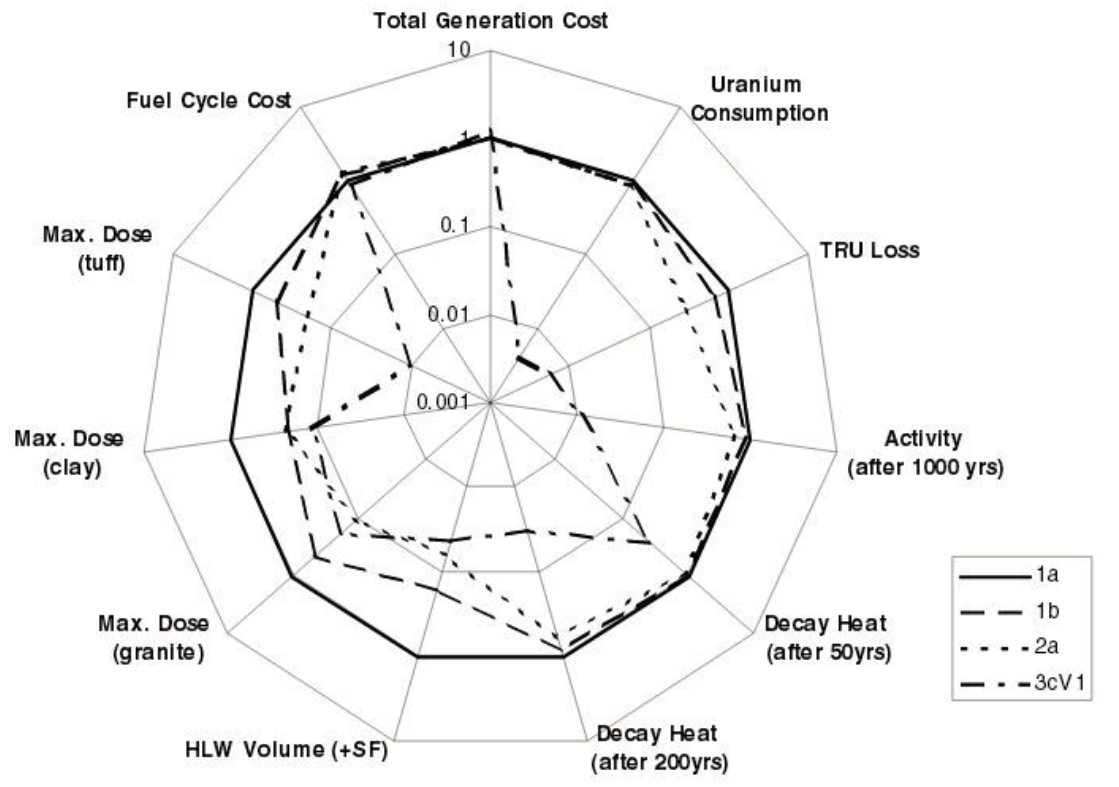
Figure 3. Comparison of eleven representative indicator values for various